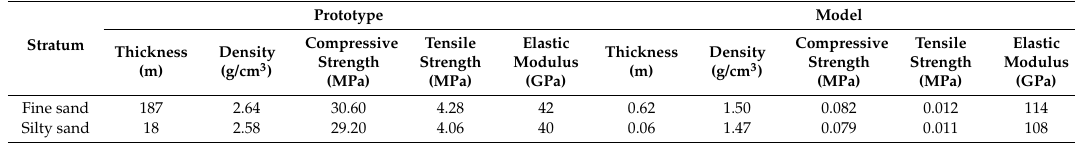
Table 1. The mechanical parameters of similar rock material.